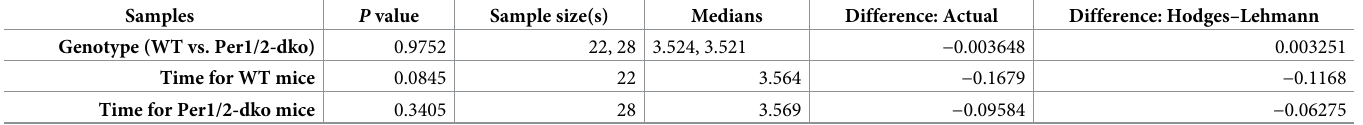
Table 1. Mann–Whitney U test for Shannon indices of pretreatment